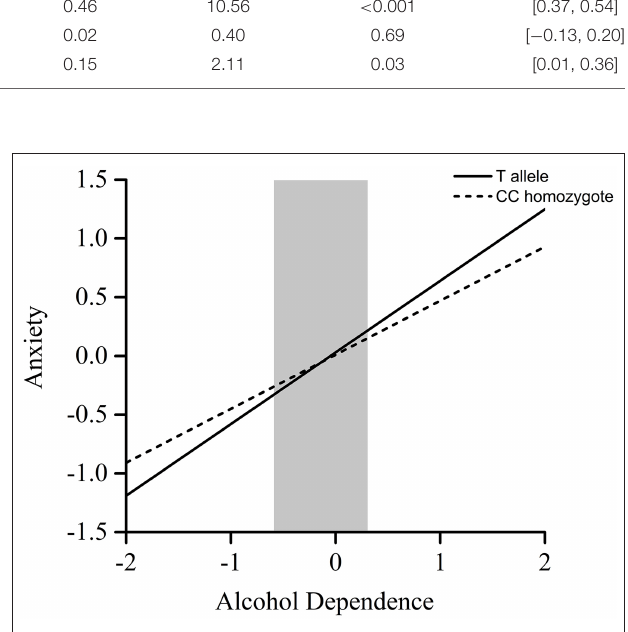
FIGURE 1 | RoS test on anxiety from alcohol dependence in POMC rs2071345 allelic groups. Gray shaded area represents 95% CI of the crossover point C of the interaction on the alcohol dependence axis. Ninety-five percent CI of C ranged from − 0.59 to